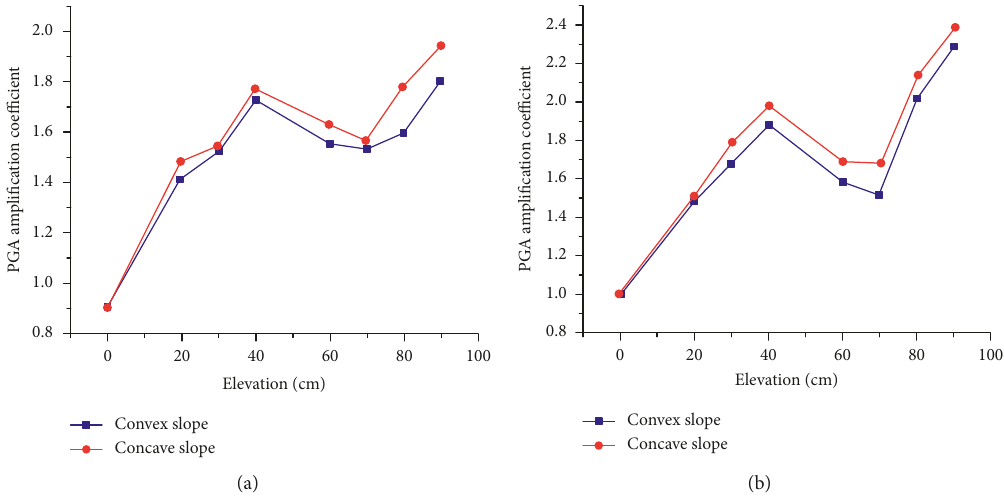
Figure 12: PGA amplification coefficients under (a) SIN-1 and (b)